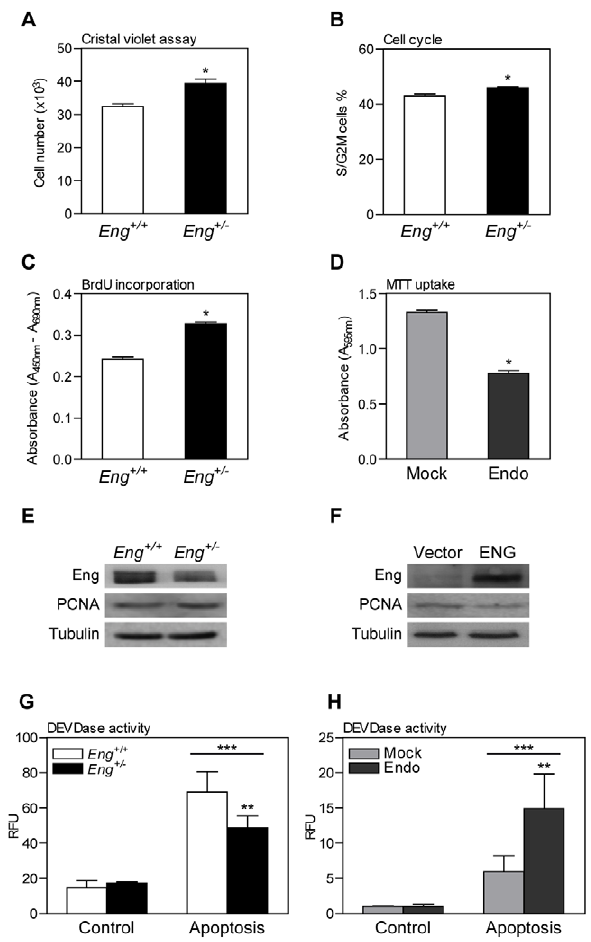
Figure 4. Effect of endoglin expression on fibroblast prolifer- ation and apoptosis. ( A–C ) Endoglin haploinsufficiency effect on MDF proliferation was estimated by crystal violet assay ( A ), cell cycle analysis ( B ) and BrdU incorporation ( C ) in proliferative conditions (10% FCS). NIH3T3 fibroblasts overexpressing human endoglin (Endo) and infected with empty vector (Mock) were used to confirm the effect of endoglin expression on fibroblast proliferation. NIH3T3 proliferation was assessed by MTT ( D ). ( E and F ) PCNA expression analyzed by western blot was compared between Eng + / + and Eng + / 2 MDF ( E ) and on Eng + / 2 MDF transfected with endoglin (ENG) or the empty vector ( F ). ( G and H ) Eng + / + and Eng + / 2 MDF ( G ) and Mock and Endo NIH3T3 ( H ) in vitro responses to apoptotic stimulus were determined by measuring DEVDase (caspase) activity after treatment with a mix of 2.5 m g/ml anti- Fas antibody plus 250 m g/ml cycloheximide. Mean + SEM is represented (n=3). * p , 0.05-significance of the difference between cells, Student’s t -test. ** p , 0.05-significance of the difference between cells in apoptosis conditions, *** p , 0.05-significance of the difference between apoptosis treatment and control conditions, Two-way ANOVA. A representative blot from three independent experiments is shown.